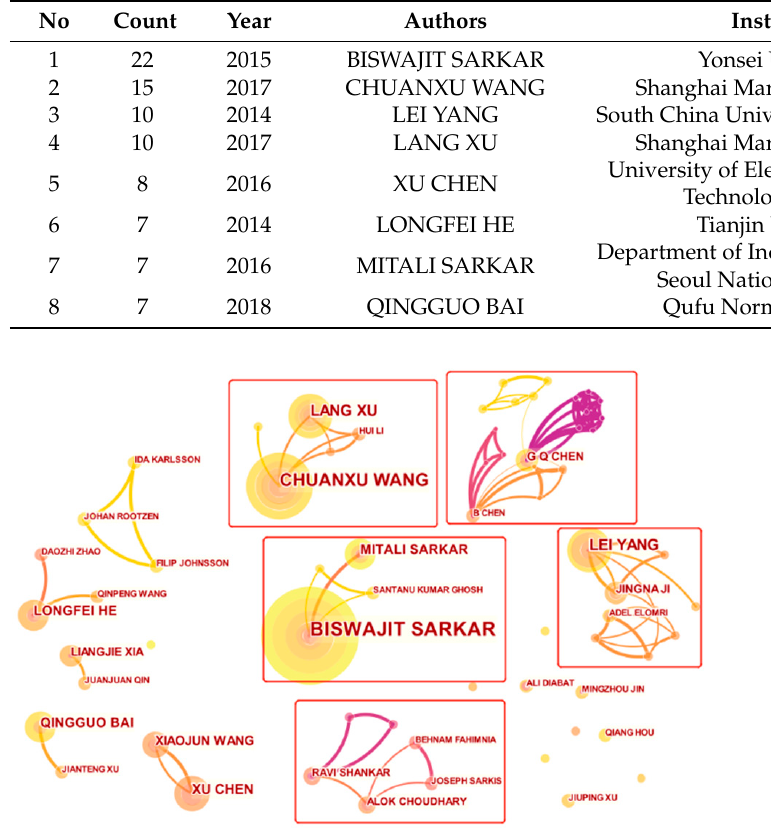
Figure 4. Visualization network map of the author co-authorship analysis.